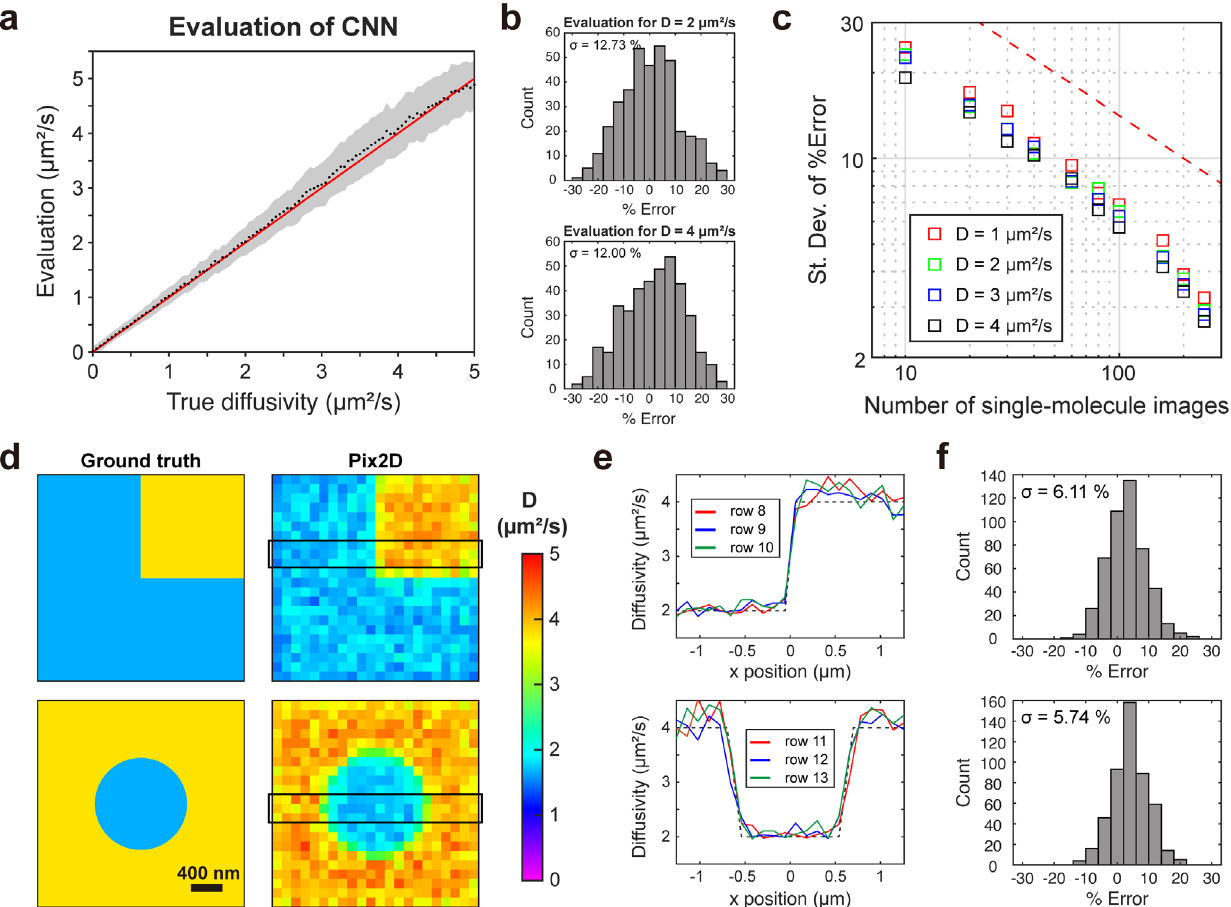
Fig. 2 Performance assessment for Pix2D CNN. a Validation of the trained CNN using simulated data not included in the training, for input channel size n = 40. For each D- value, evaluations were performed for 400 sets of n ch ch images, and the average value and standard deviation were plotted as a black marker and the shaded area, respectively. Red line: reference (evaluation equaling the ground truth). b Distributions of relative errors (%Error) for training labels of D = 2 and 4 µ m 2 /s. c Standard deviations of %Error for D = 1, 2, 3, and 4 µ m 2 /s for different counts of starting single-molecule images ( p i ), but fi xed n ch = 40. Red dashed line: trend based on MLE analysis of the distribution of single-molecule step distances. d Spatial mapping of simulated data. (Left) Ground truths of simulated patterns with spatially varied D- values. (Right) Pix2D mapping results at a binning grid size of 120 nm, so that each bin counted ~200 simulated single-molecule images. e Line pro fi les in three rows of the Pix2D mapping results along the black boxes in d . Dashed line: reference line of ground truth diffusivity. f Distribution of the %Error of Pix2D results in the different spatial bins, for all bins in d .